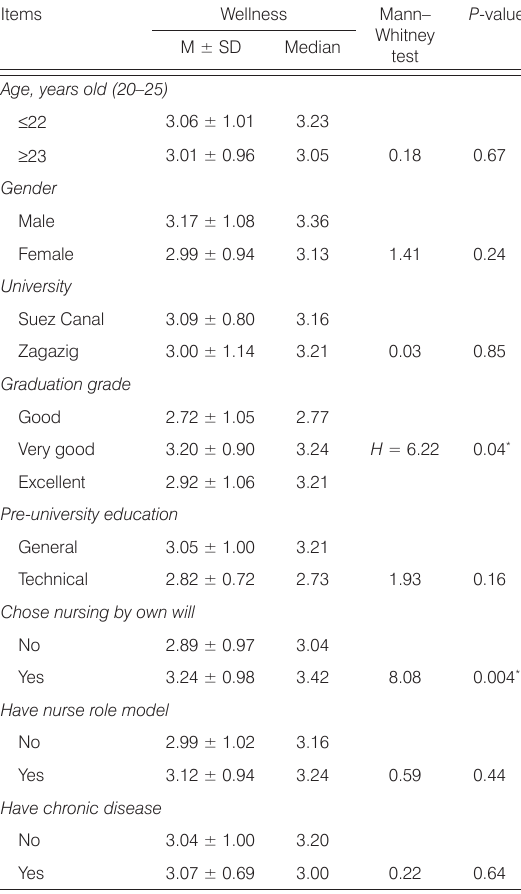
Table 3. Relations between nurse interns’ professional identity scores and their personal